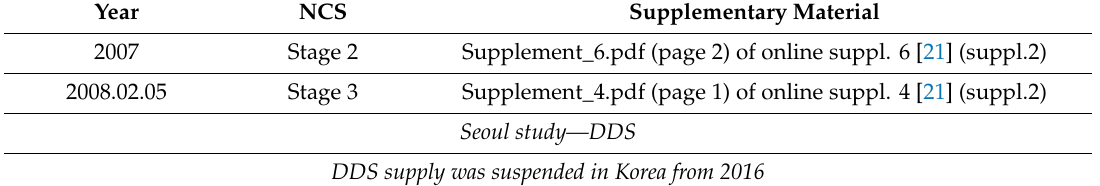
Table 4. Treatment of neuroinflammation with anti-Alzheimer’s disease drug (AAD) used as a new biomarker of numeric clinical staging (NCS)—a new biomarker of numeric clinical staging (NCS) is denoted as (D). (D) (added NCS is italicized) (Supplement.